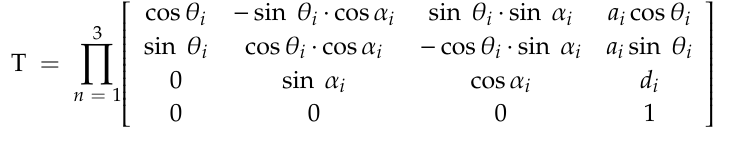
Table 1. Denavit – Hartenberg (DH) parameters on the extra robotic fingers.